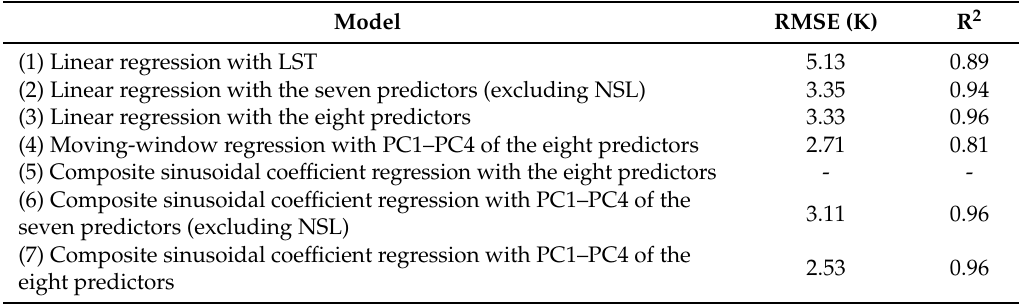
Table 3. Averaged error of different regression models according to